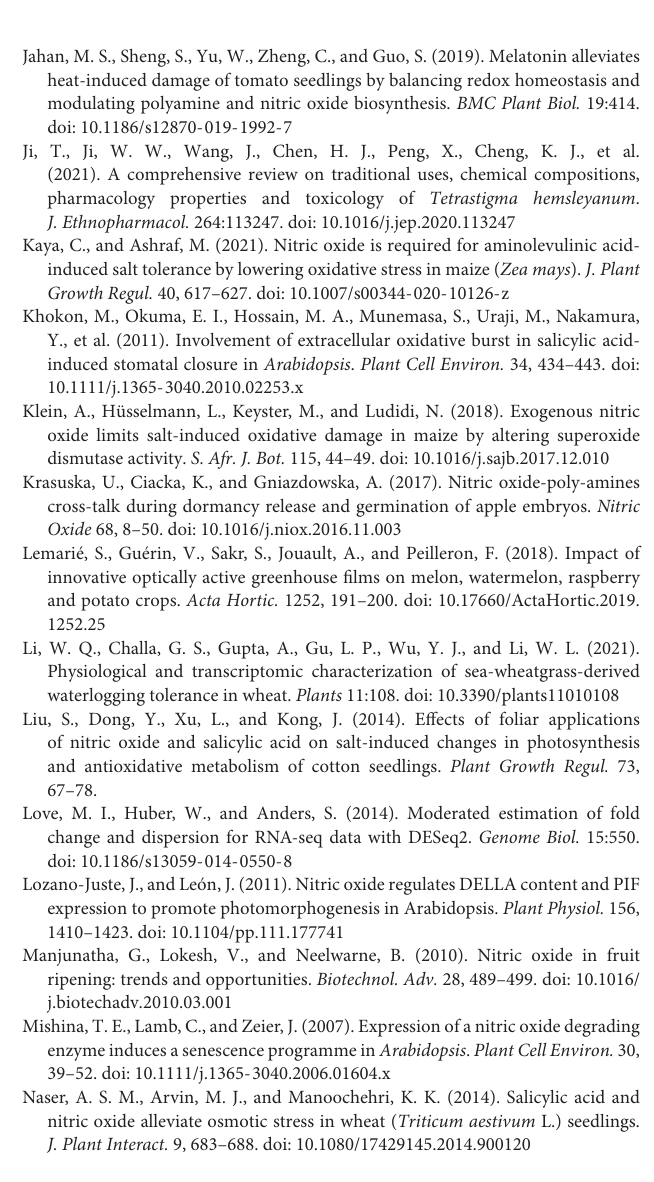
Supplementary Table 4 | All DEGs encoding proteins involved in photosystem I (PS I) and photosystem II (PS II) reaction center between GZ vs. GF